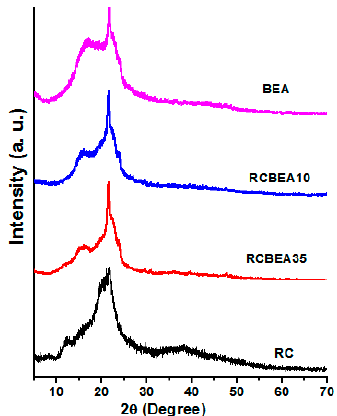
Figure 4. Wide angle X-ray diffraction (WAXD) patterns of the regenerated cellulose (RC) film, bisphenol A epoxy acrylate resin, and some composite films.